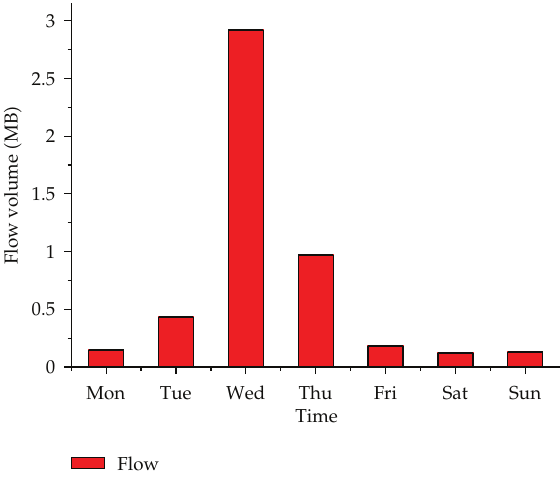
Figure 3: Tra ffi c volumes indexed by a